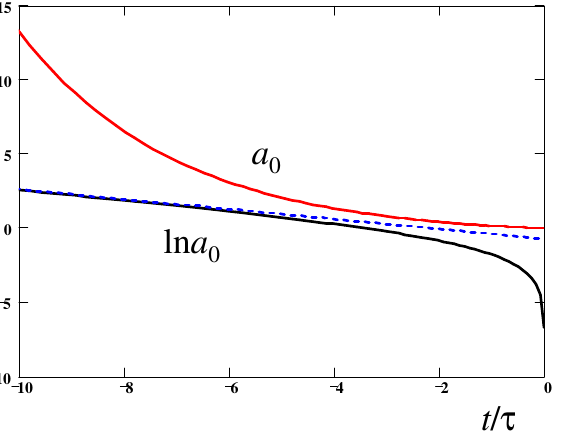
Figure 6. Time dependencies of X and s (vs. t / τ ); t = 0 is the putative breakup point.